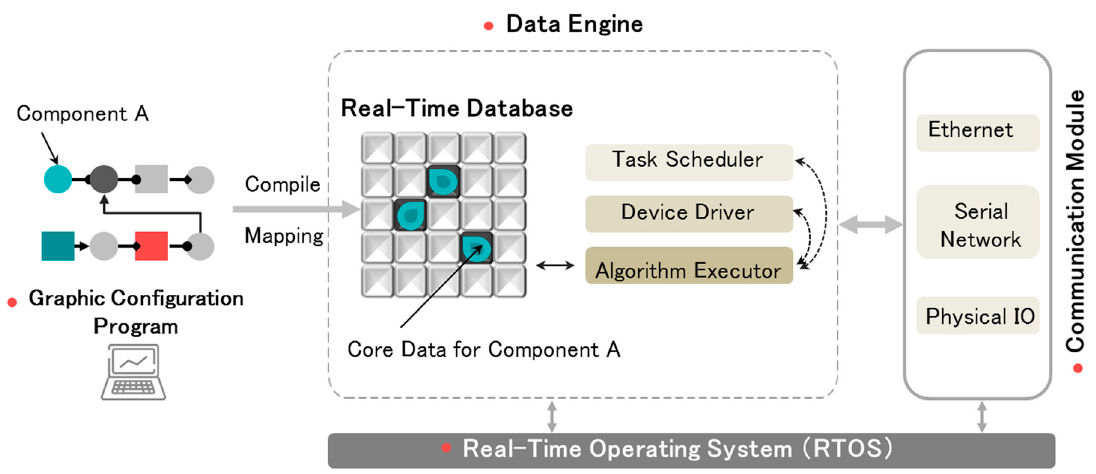
Figure 1. Data Engine scheme.